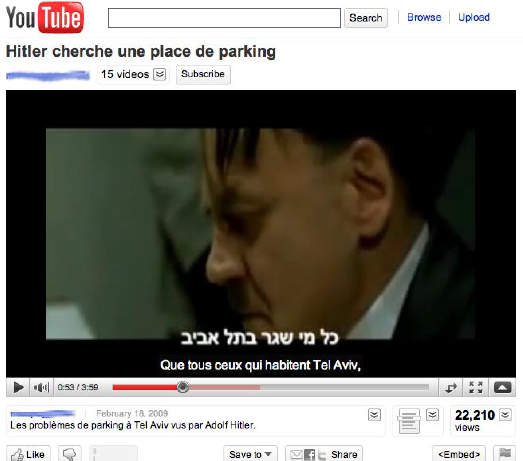
Figure 4: Video“Hitler cherche une place de parking.” Screenshot taken on July 12,